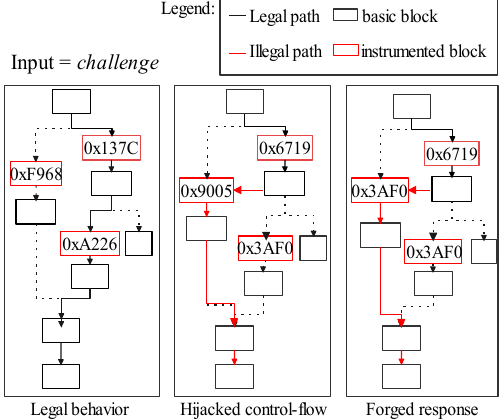
Figure 3. Forge a legalized response(R’) after the